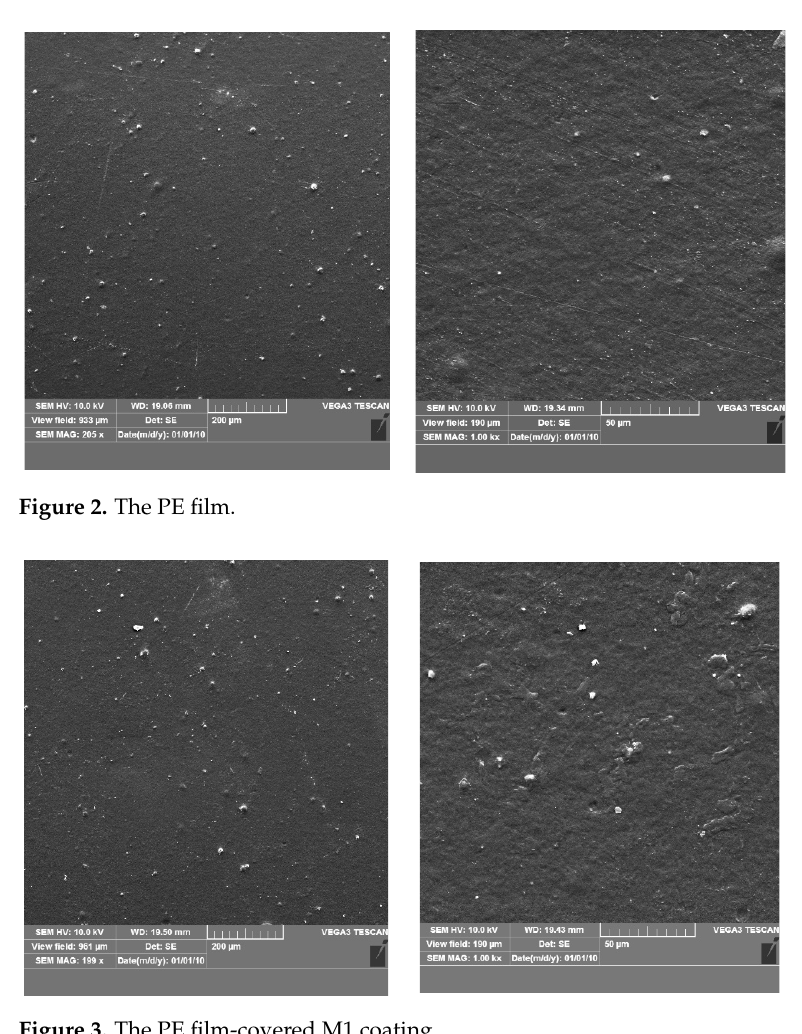
Figure 3. The PE film-covered M1 coating.